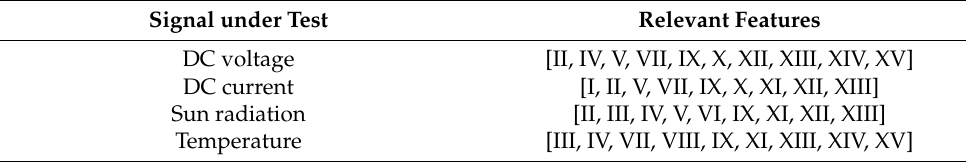
Table 4. Resulting set of optimized features per